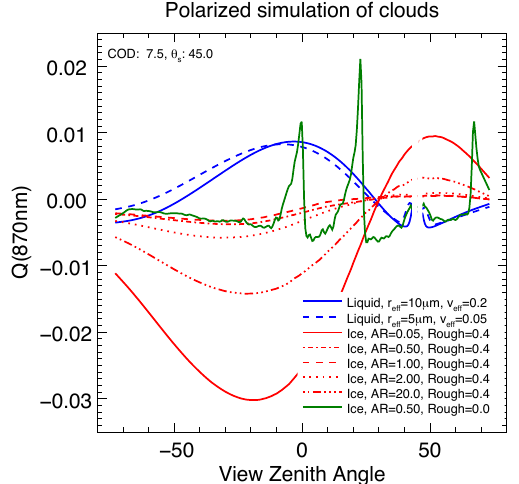
Figure 6. Simulated Q with respect to view zenith angle for liquid (blue) and ice clouds, including an ice cloud comprised of pristine crystals (green, roughened crystal clouds are shown in red). The roughness factor, which is 0 for pristine crystals and increases with surface facet randomization, is defined according to Macke et al. (1996). Both the 22 and 46 ◦ halos (at zenith angles of roughly 23 and 67 ◦ for the 22 ◦ halo, and 0 ◦ for the 46 ◦ halo) are clear for the pristine ice crystal cloud.